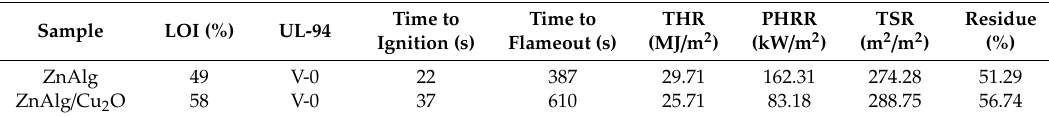
Table 1. limiting oxygen index (LOI), vertical burning rate (UL-94) testing results and combustion parameters of the prepared samples. Table 1. Limiting oxygen index (LOI), vertical burning rate (UL-94) testing results and combustion parameters of the prepared samples.